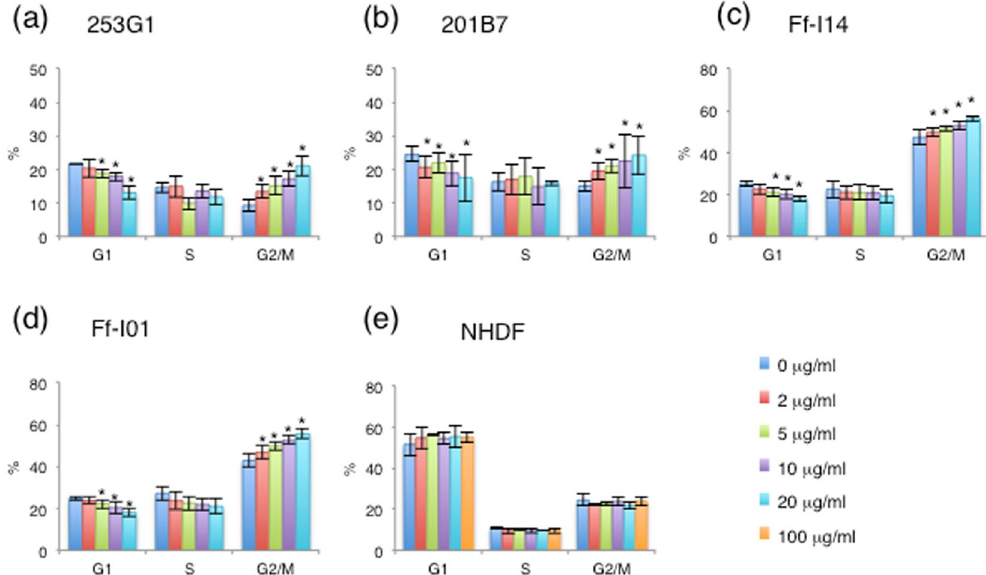
Figure 3. Effect of brentuximab vedotin on cell cycle ( a ) 253G1 cells, ( b ) 201B7 cells, ( c ) Ff-I14 cells, ( d ) Ff- I01 cells, and ( e ) NHDFs were treated with increasing concentrations of brentuximab vedotin. At 10 h after treatment, cells were stained with propidium iodide (PI) to detect DNA content and analysed by flow cytometry. Bar graphs indicate the percentage of cells in different phases of the cell cycle. Data were collected from at least three independent experiments. * p < 0.05 vs. 0 μ